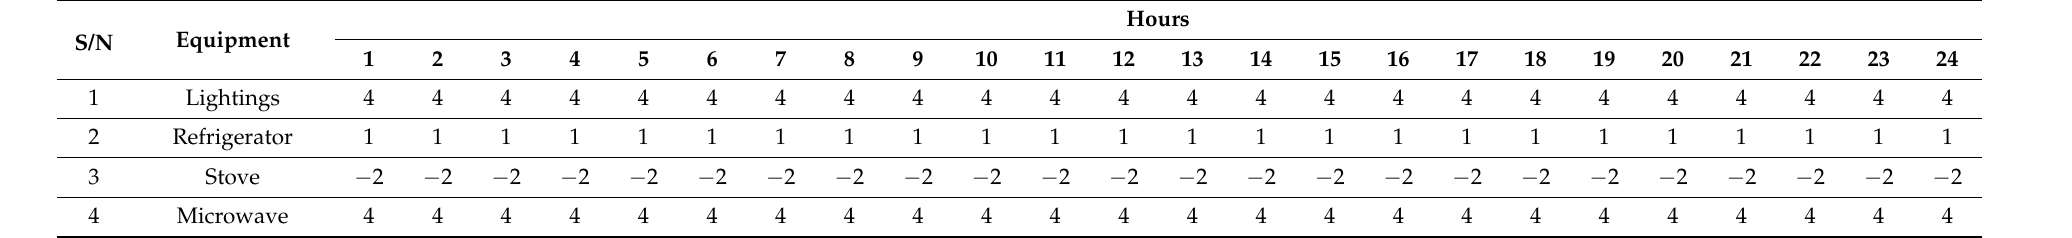
Table 4. Device-based